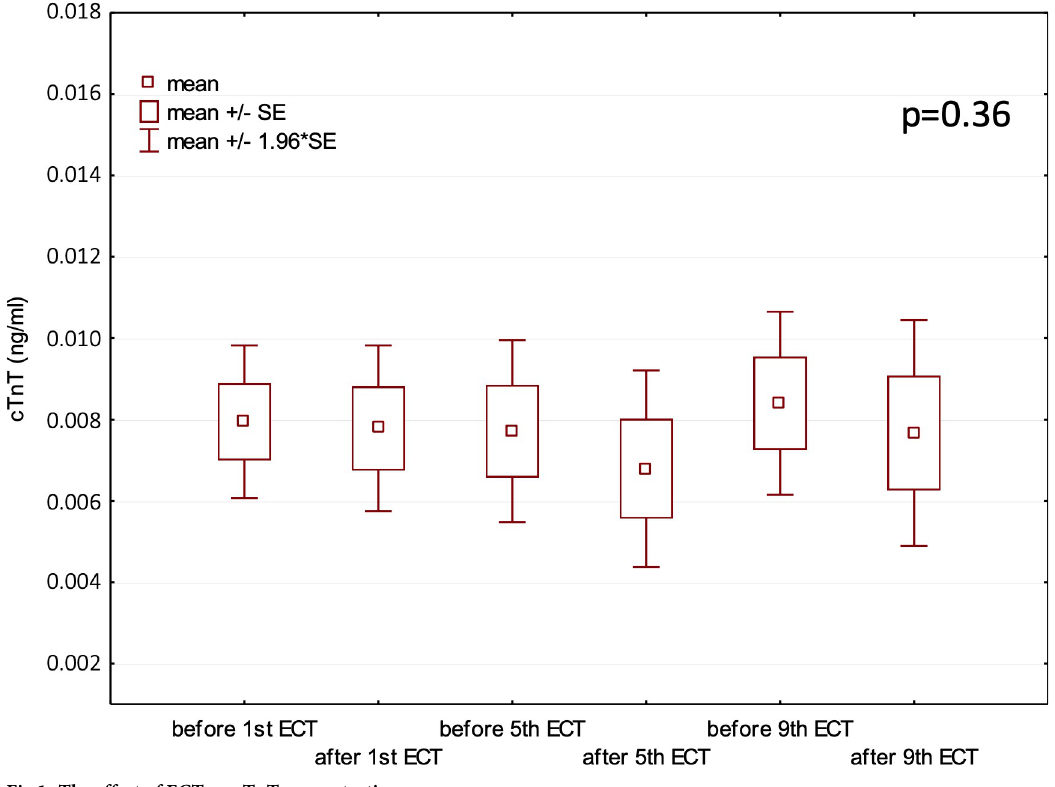
Fig 1. The effect of ECT on cTnT